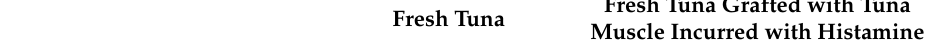
Table 4. Histamine concentrations detected in fresh tuna and fresh tuna grafted with tuna muscle nat- urally incurred with histamine at 6000 mg/kg level after storage at different temperature conditions (trial